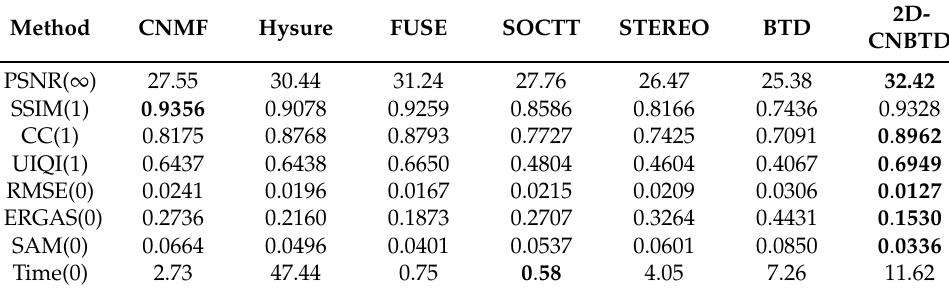
Table 3. Performance for Indian